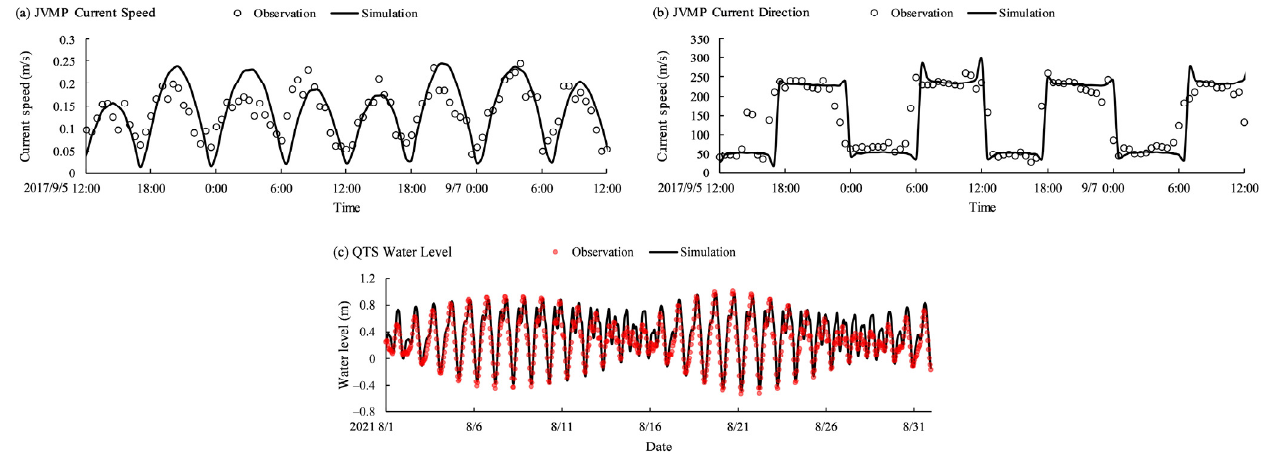
Figure 4. Comparison between the observed and simulated values for the current speed and direction at measuring point JVMP from 12:00 5 September 2017, to 12:00 7 September 2017, and the water level at tidal station QTS during August 2021, for the Jinmeng Bay